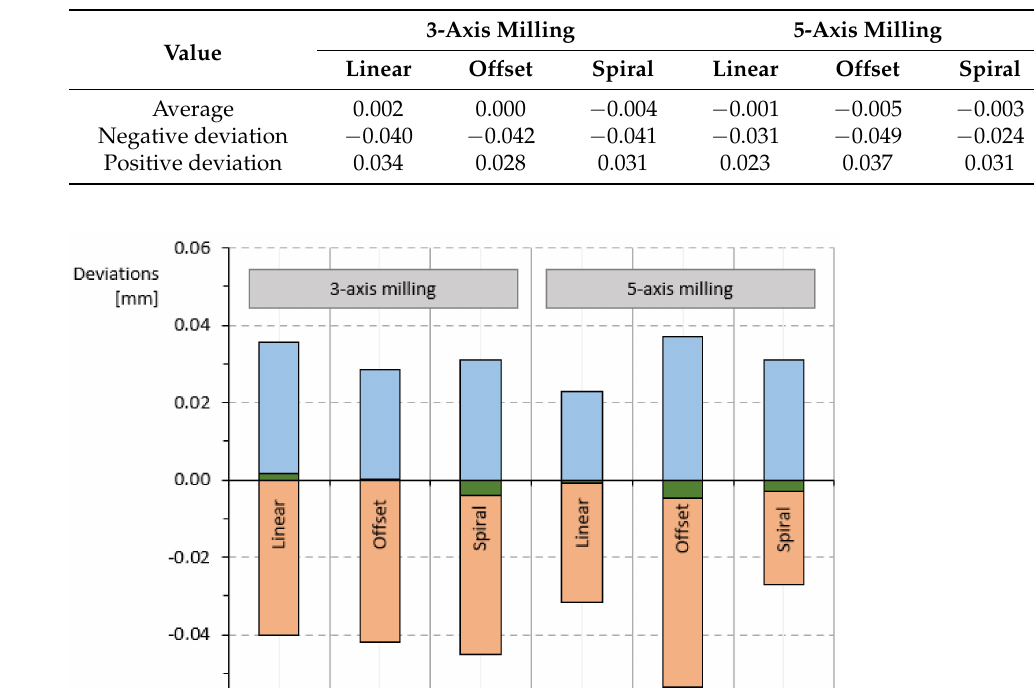
Table 4. Deviation values [mm] for samples made by 3-axis and 5-axis milling.